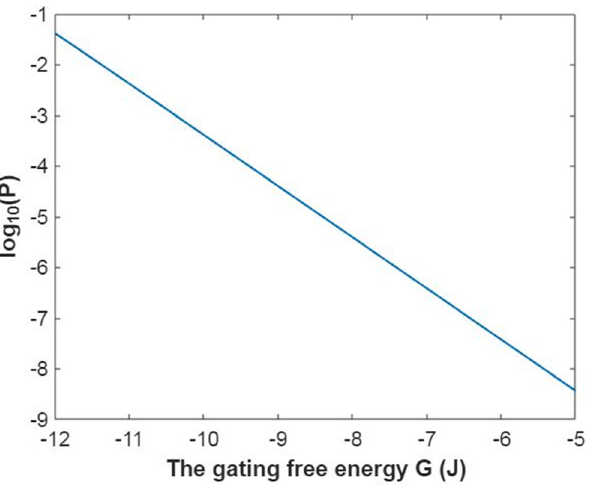
Figure 18. The relationship between gating free energy and the common logarithm of the open probability of potassium channels at membrane potential − 0.087 V and over a gating free energy range from − 12 J to − 5 J. The membrane conductance of potassium ions at G = − 5.35 J: 5.35 153.6 10.43 The relationship between membrane potential and the common logarithm of the membrane conductance of potassium ions is plotted according to Equation (44) as in Figure 19.